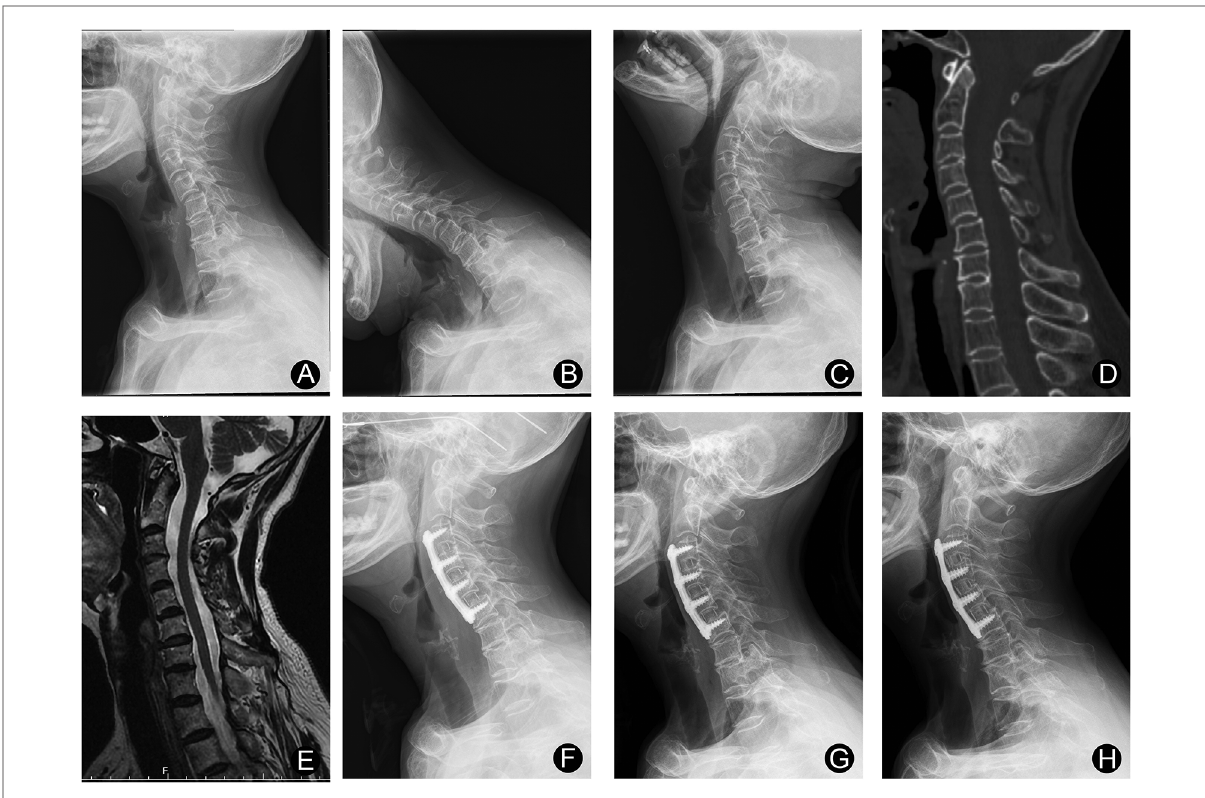
FIGURE 2 Female, 68 years old: three levels of ACDF was experienced. ( A – C ) Cervical spine x-ray showing C3/4, C4/5 and C5/6 instability. ( D ) Preoperative cervical CT sagittal image. ( E ) Magnetic resonance imaging (MRI) showing no signi fi cant compression of the spinal cord. ( F ) x-ray of cervical spine 3 months after surgery. ( G ) x-ray of cervical spine 12 months after surgery. ( H ) x-ray of cervical spine 24 months after